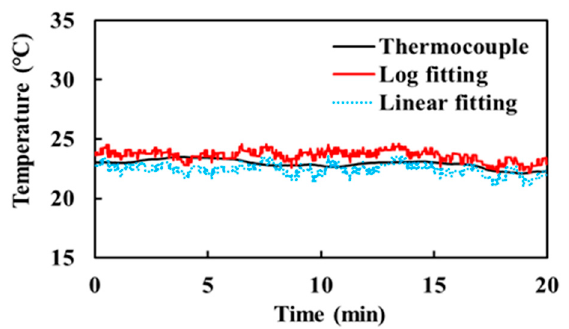
Figure 9. Measurement of water at ambient temperature.